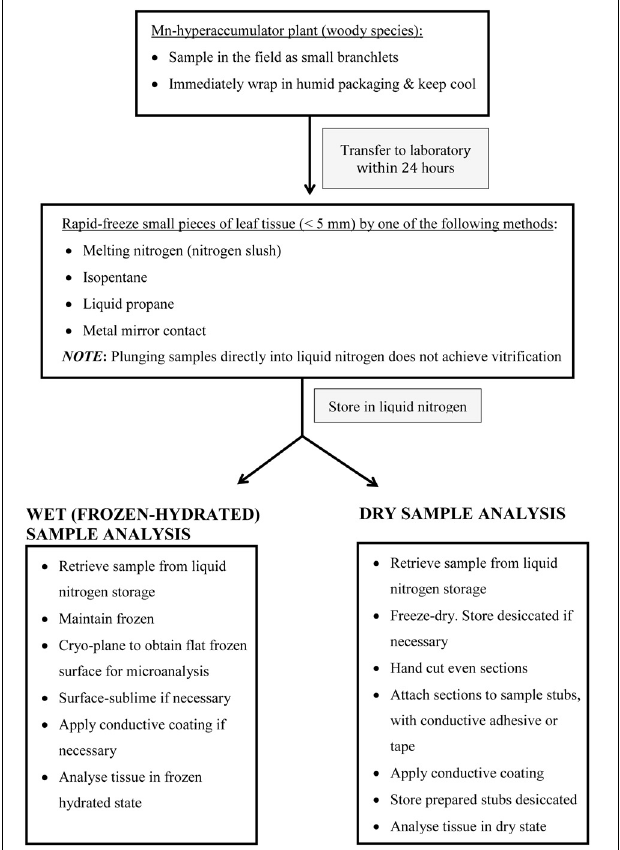
FIGURE 3 | Schematic summary of important steps in preparing (woody) Mn hyperaccumulator leaf-tissue for in vivo microprobe